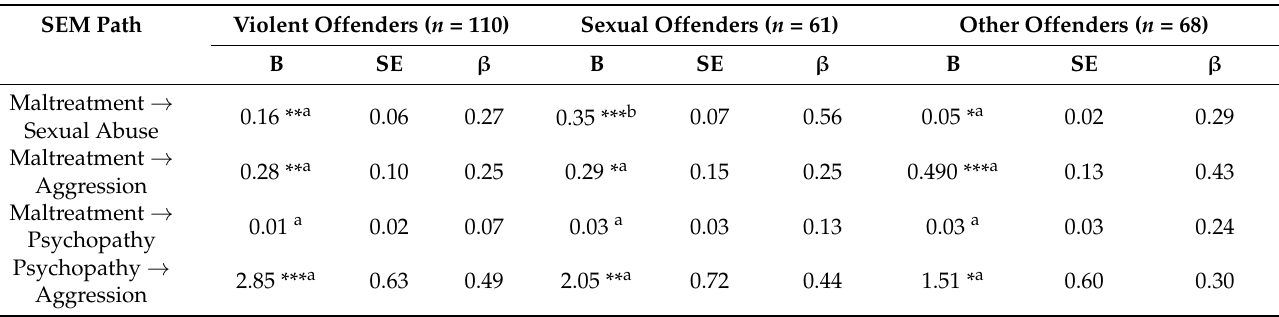
Table 2. SEM path loadings across offender